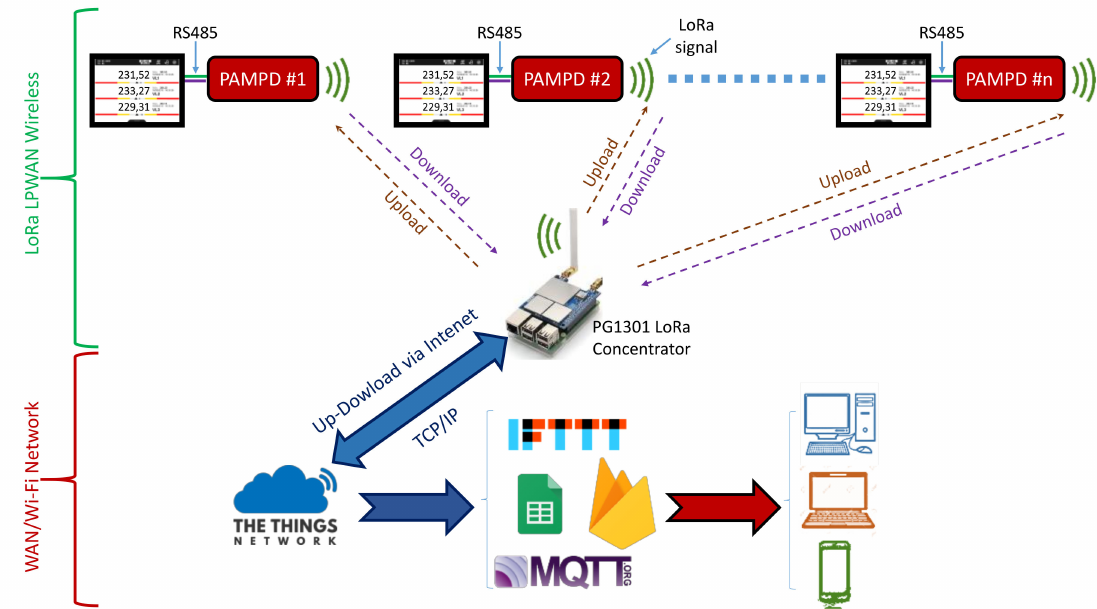
Figure 1. Architecture of the proposed